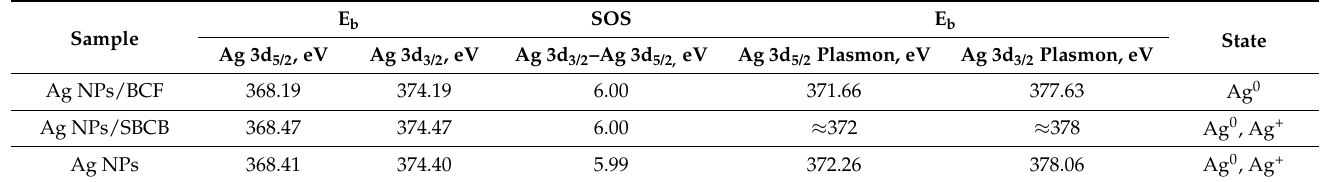
Figure 9. The Ag 3d photoelectron spectra of samples Ag NPs/BCF (a), Ag NPs/SBCB (b) and Ag NPs (c). Table 5. Characteristics of the Ag 3d photoelectron spectra: binding energies (E b ) and spin-orbit splitting